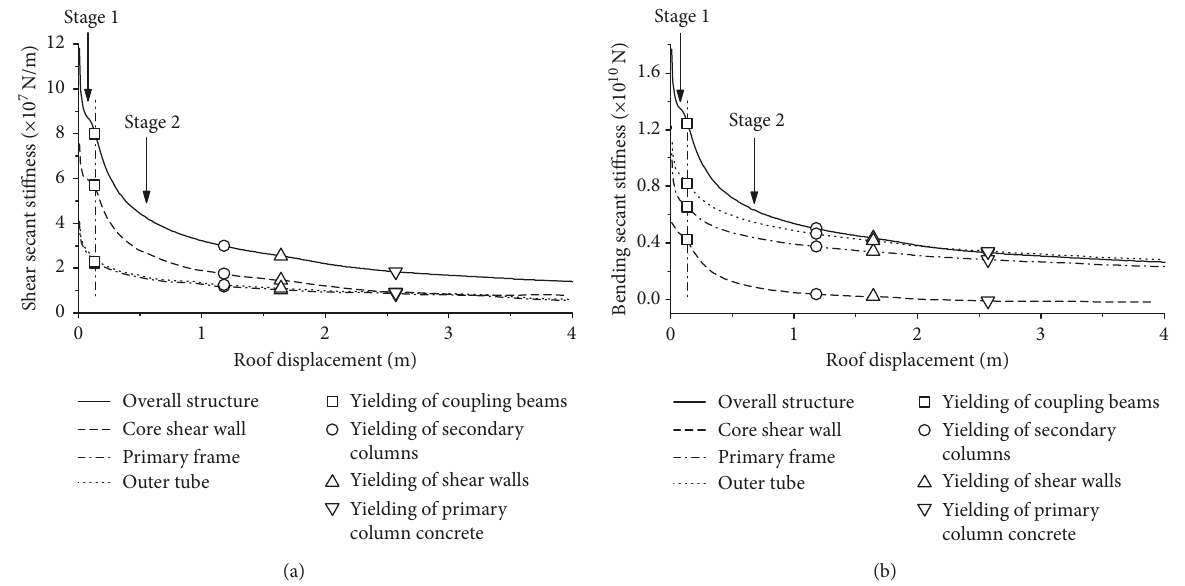
Figure 19: Stiffness degradation process of model 5MC: (a) shear stiffness degradation; (b) bending stiffness degradation.